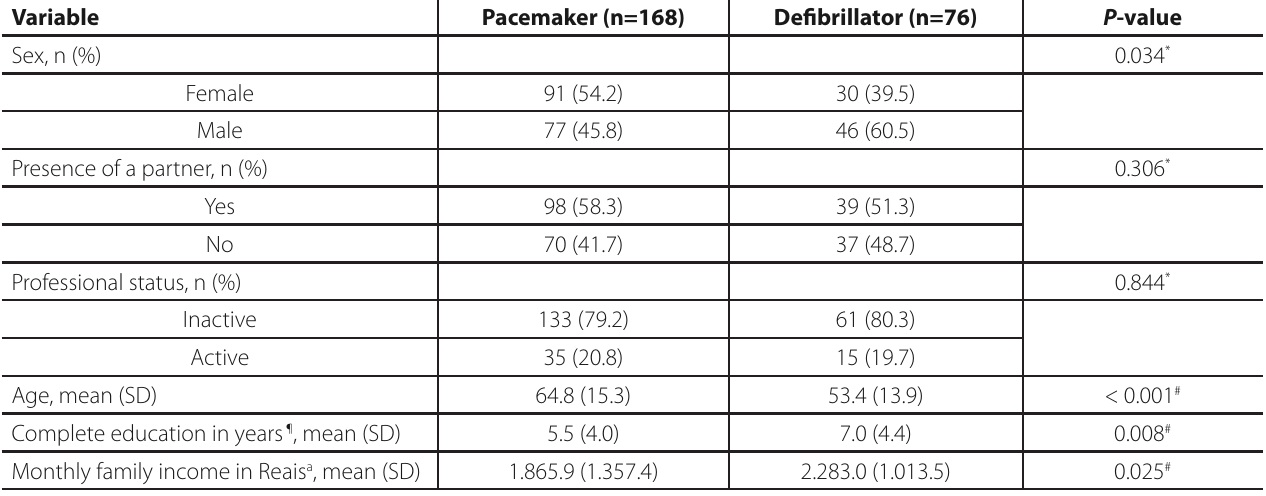
Table 1 . Sociodemographic characterization of the 244 participants according to the type of device (implantable cardiac pacemaker and implantable cardioverter defibrillator). Ribeirão Preto,